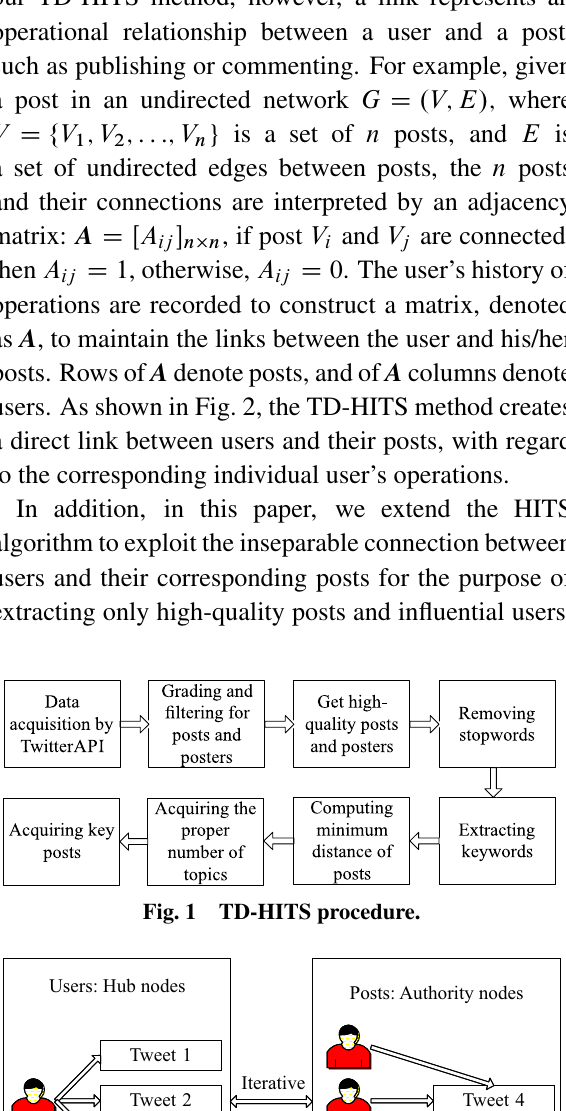
Fig. 1 TD-HITS procedure.